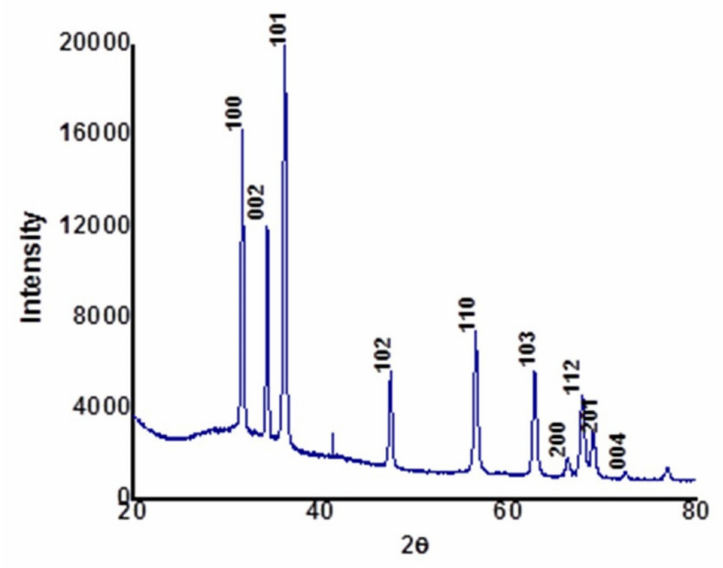
Figure 1. ( A ) The absorption and ( B ) emission spectra of as-obtained ZnONPs.